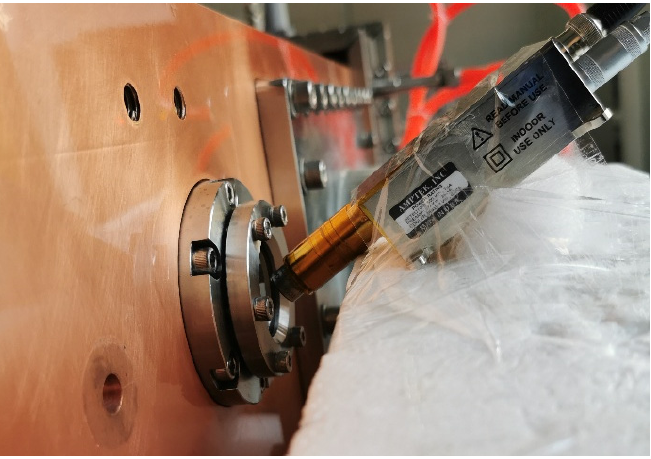
Figure 10. The quartz window and spectrometer. In the measurement, we used a 1.0 mm thick copper absorber plate to filter out low- energy peaks and backgrounds. A typical 1X-ray spectrum corresponding to the RFQ inter-vane voltage is shown in Figure 11. There are different ways of quantifying the cutoff energy [16–18]. We adopted linear fitting with a beveled edge for the high energy region and took the horizontal intercept as the cutoff energy. The specific shunt impedance is defined as follows: